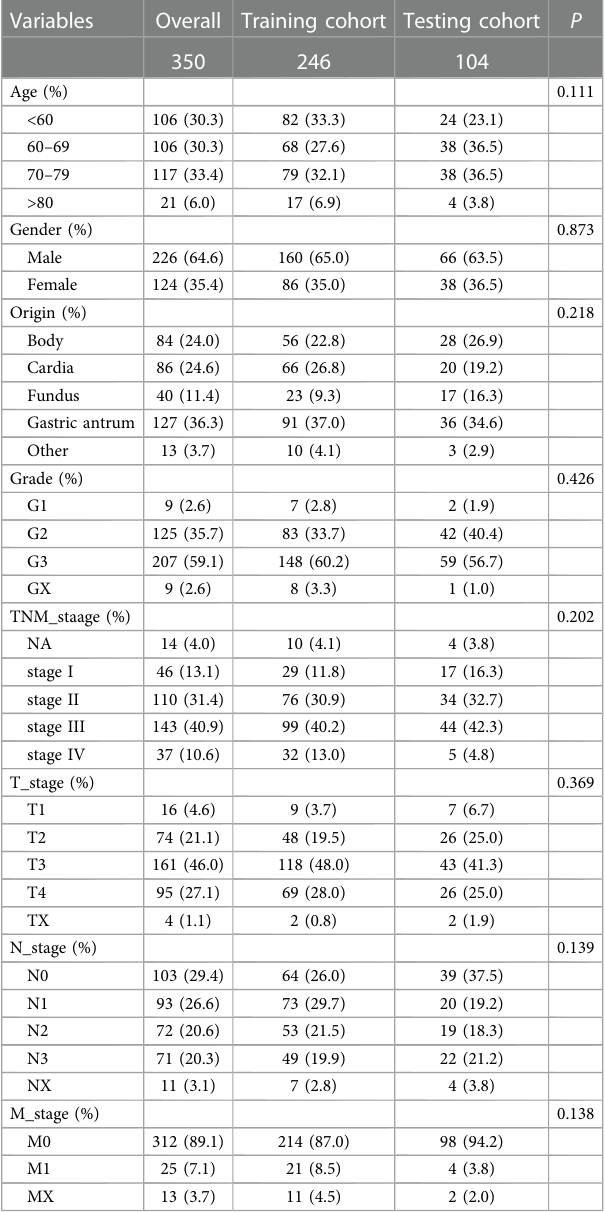
TABLE 2 Distribution of clinical baseline data of gastric cancer patients in training and testing cohorts.